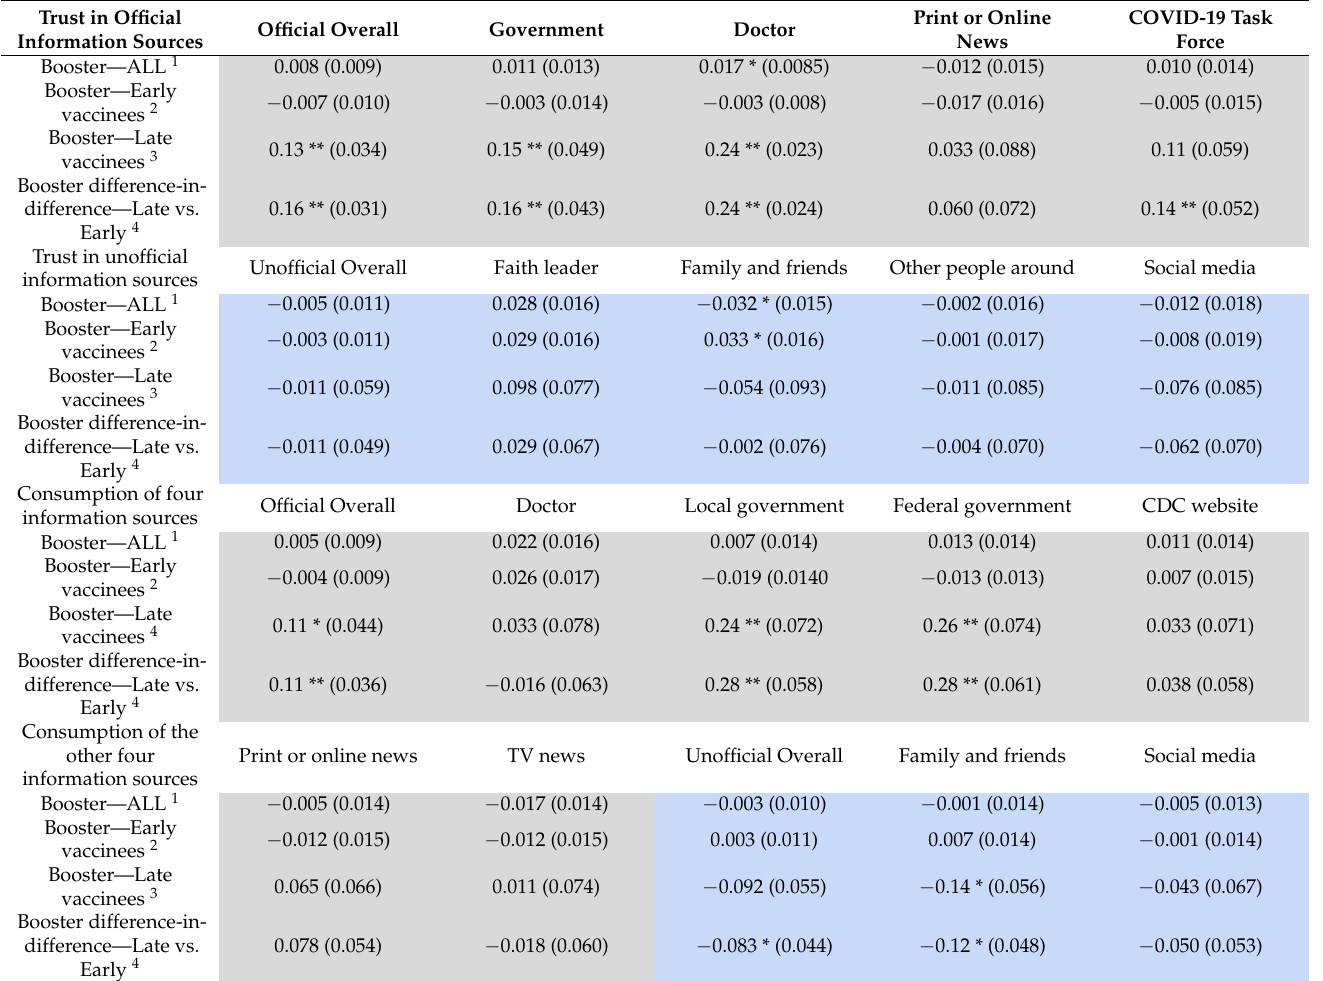
Table A3. Demographic statistics on the survey data, including descriptive statistics showing the count and percentage of participants at each vaccination stage. In addition, the numbers of returning participants at all vaccination stages are shown.